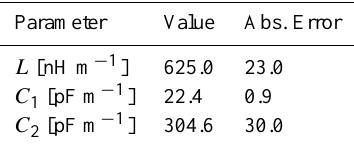
Table 1. Probe parameters estimated based on Eqs. (5) and (9) and absolute errors calculated with Gauss